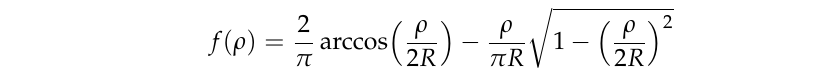
E 46 , respectively, 25 5